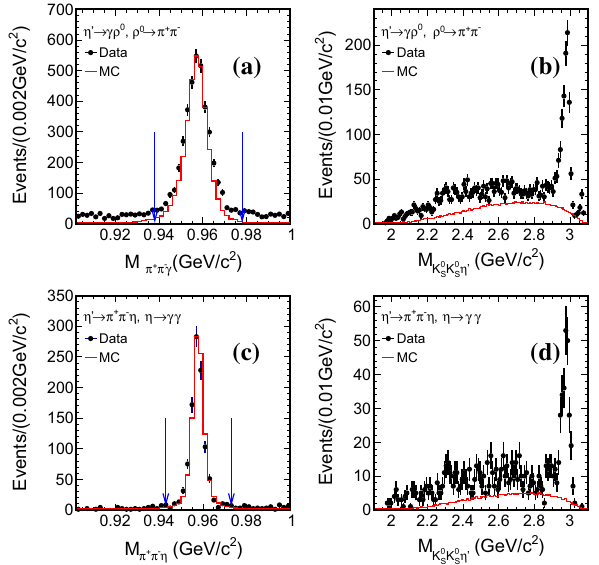
η (cid:3) K 0 S S